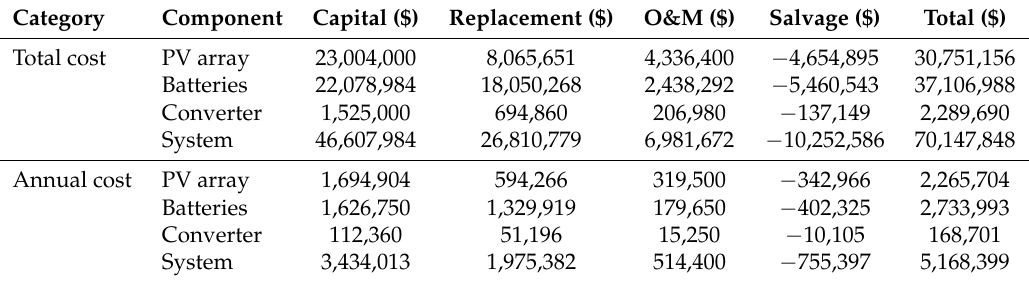
Table 6. Total and annual costs of the optimal configuration (created by the